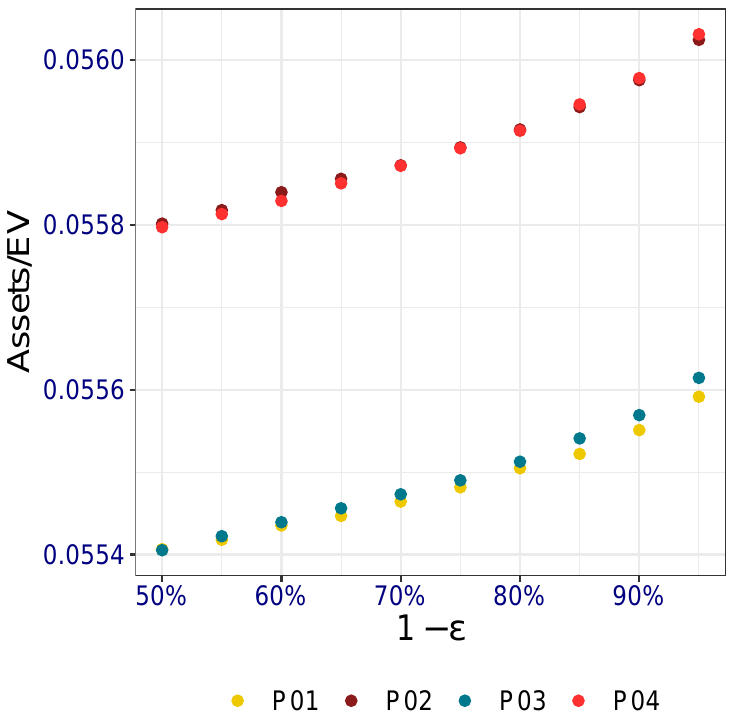
Figure 11. Impact of the portfolio structure on assets requirements at time t =